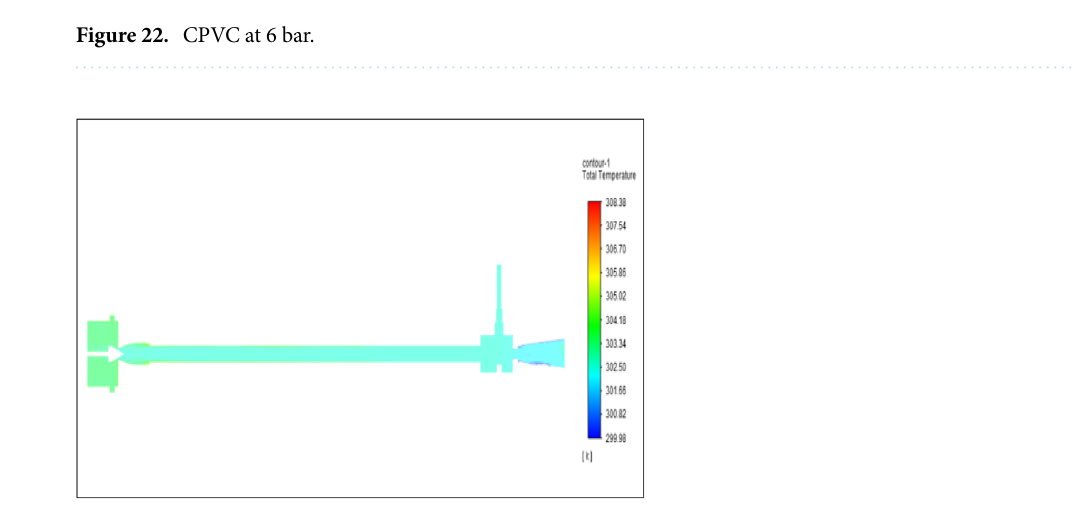
Figure 23. Acrylic at 6